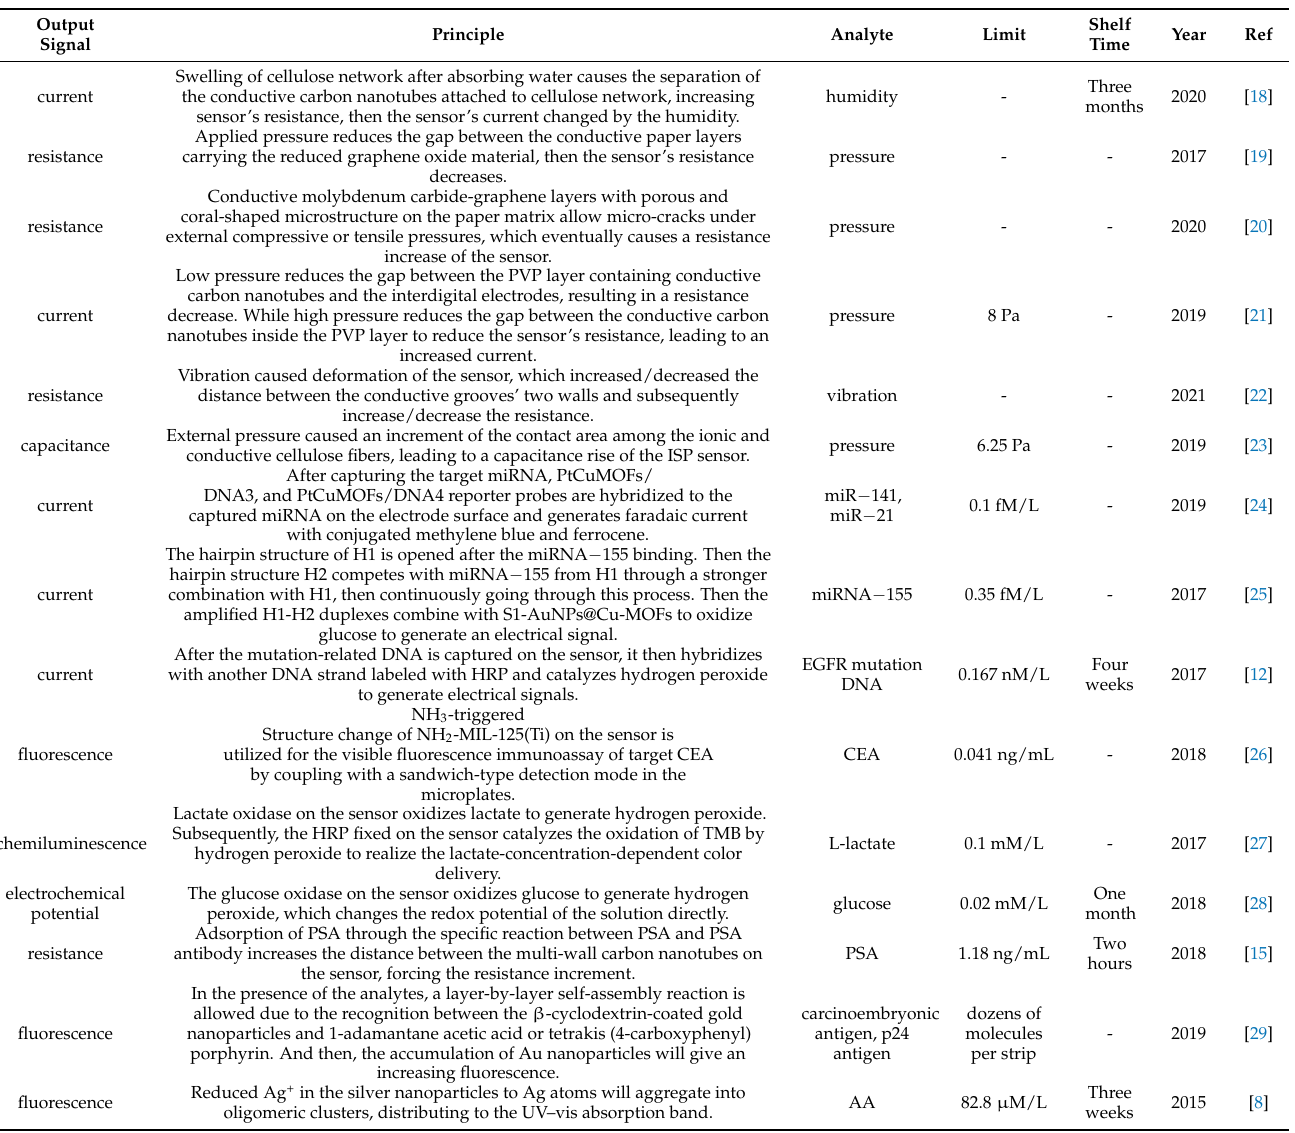
Table 1. Paper-based sensors for physical, biological, and chemical factor sensing on account of the output signal, working principle, analyte, detection limit, and shelf time. Output Signal Principle